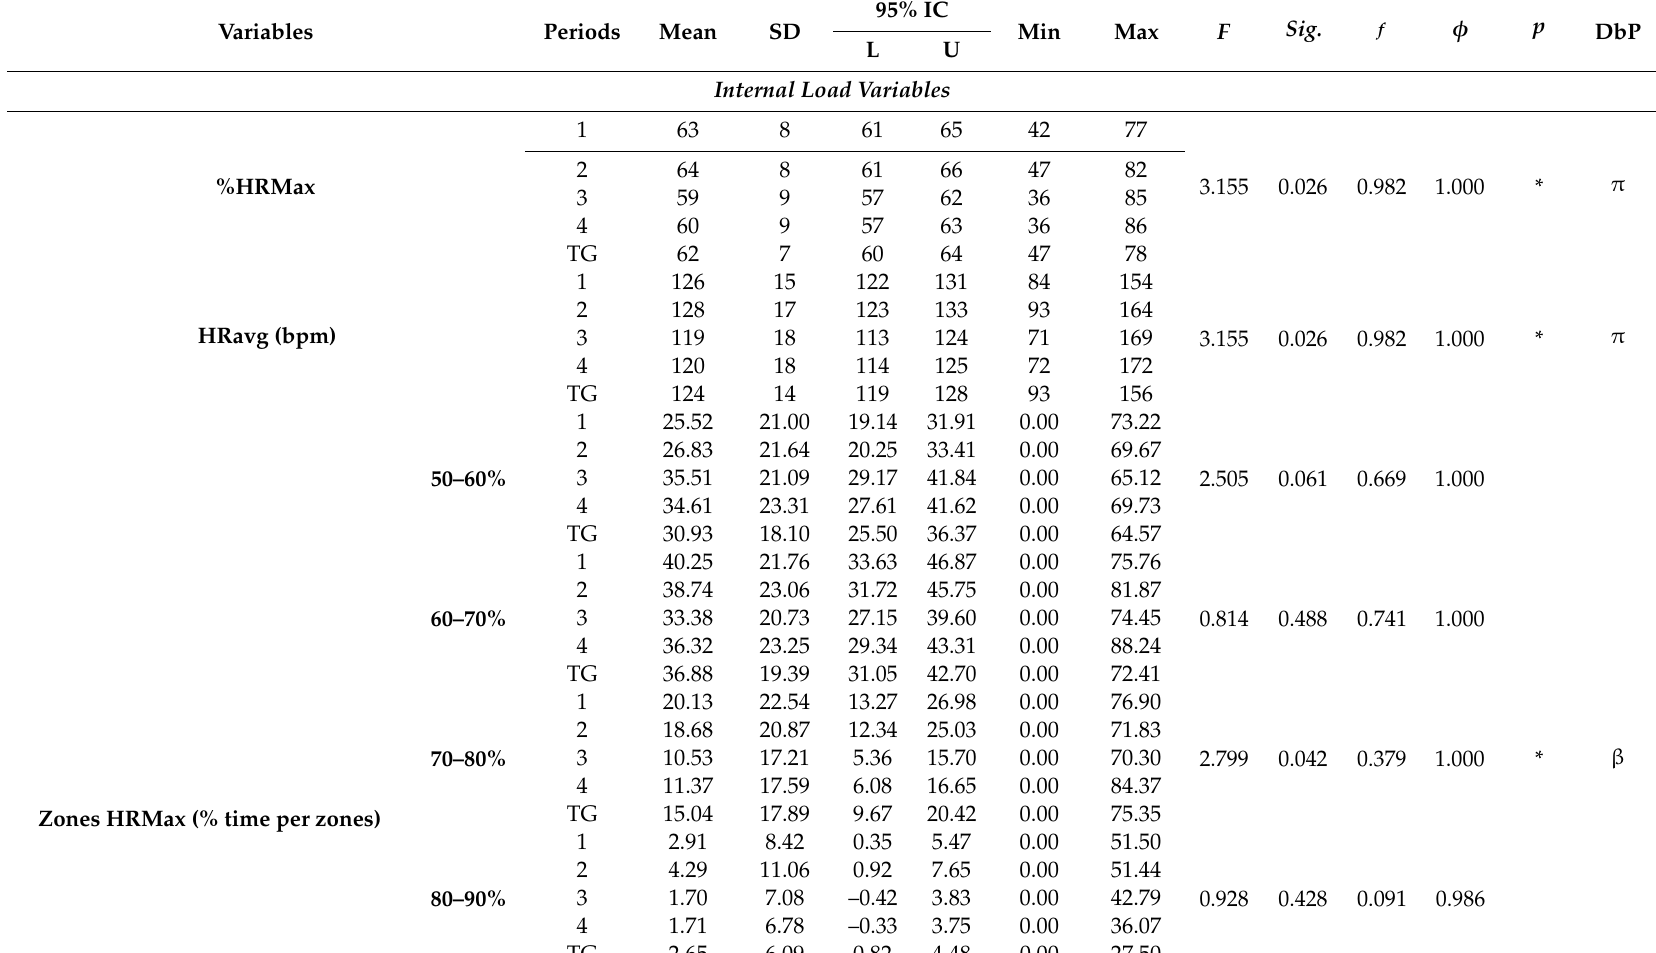
Table 2. Descriptive and Inferential Results of the Internal Load